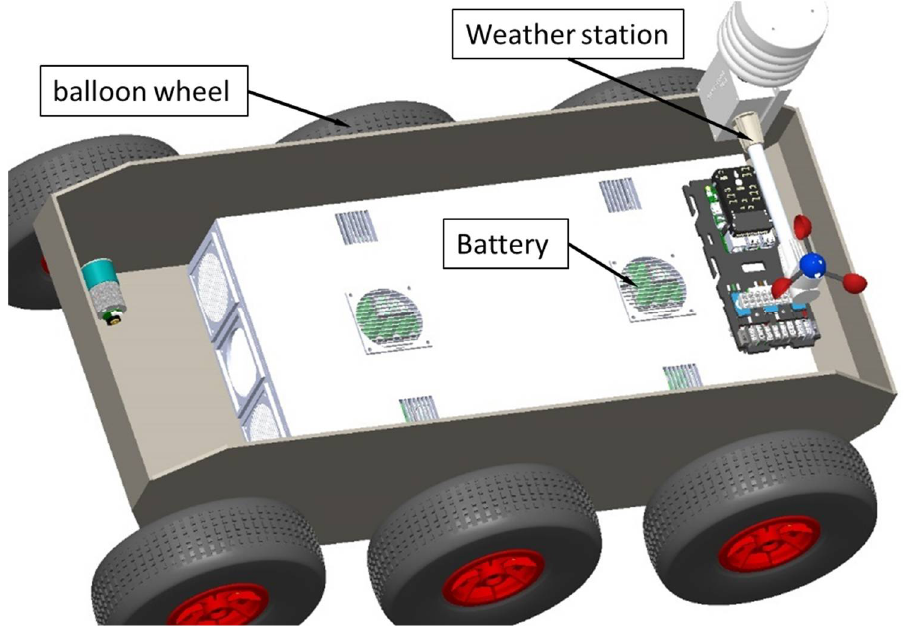
Figure 1. The terrestrial 6 × 6 robot developed for identifying, monitoring, and intervening in risky areas. The structural elements of the robot include the command-and-control system, the battery system, and the weather station.